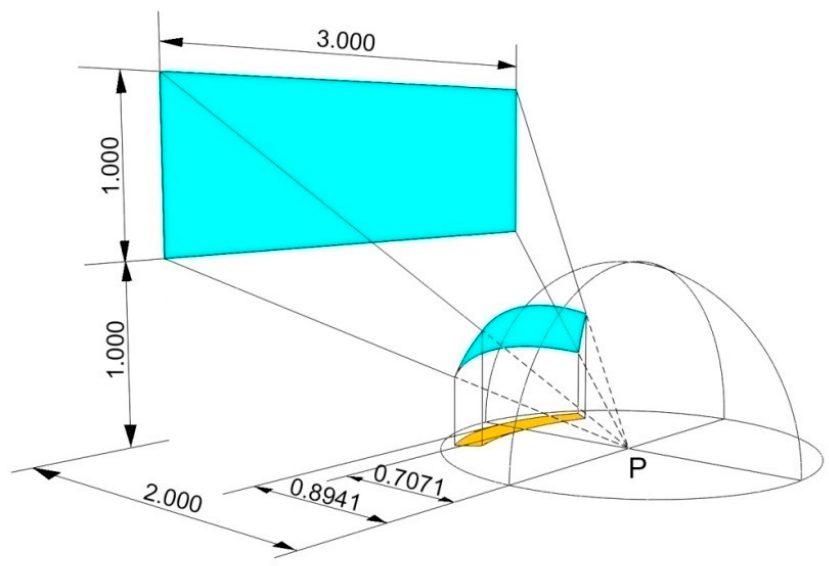
Figure A4. Scheme of a ‘rectangle’ type to employ in Figure A6 . Scheme of a ‘rectangle’ type to employ in calculations.